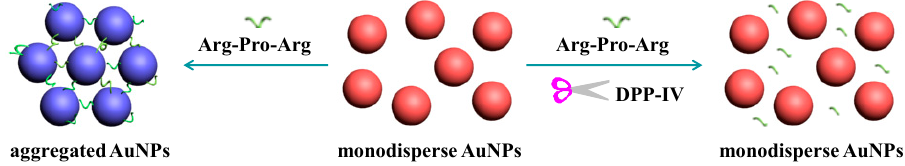
Scheme 1. Schematic illustration of the colorimetric assay of dipeptidyl peptidase-IV (DPP-IV) activity using gold nanoparticles (AuNPs) as the probes.